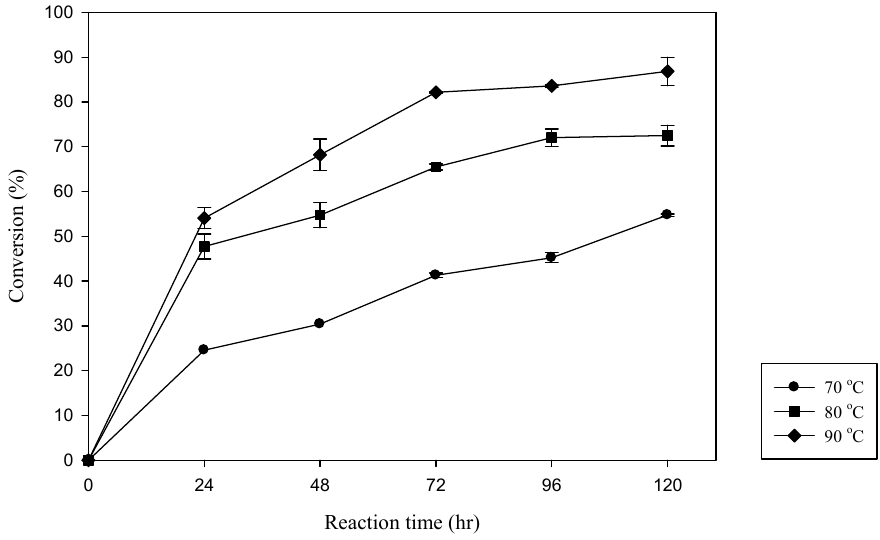
Figure 2. Effects of reaction temperature and time on Novozym ® 435-catalyzed synthesis of octyl ferulate. The reaction was employed in a water bath at a reaction temperature of 70–90 °C and enzyme amount of 1500 propyl laurate units (PLU).